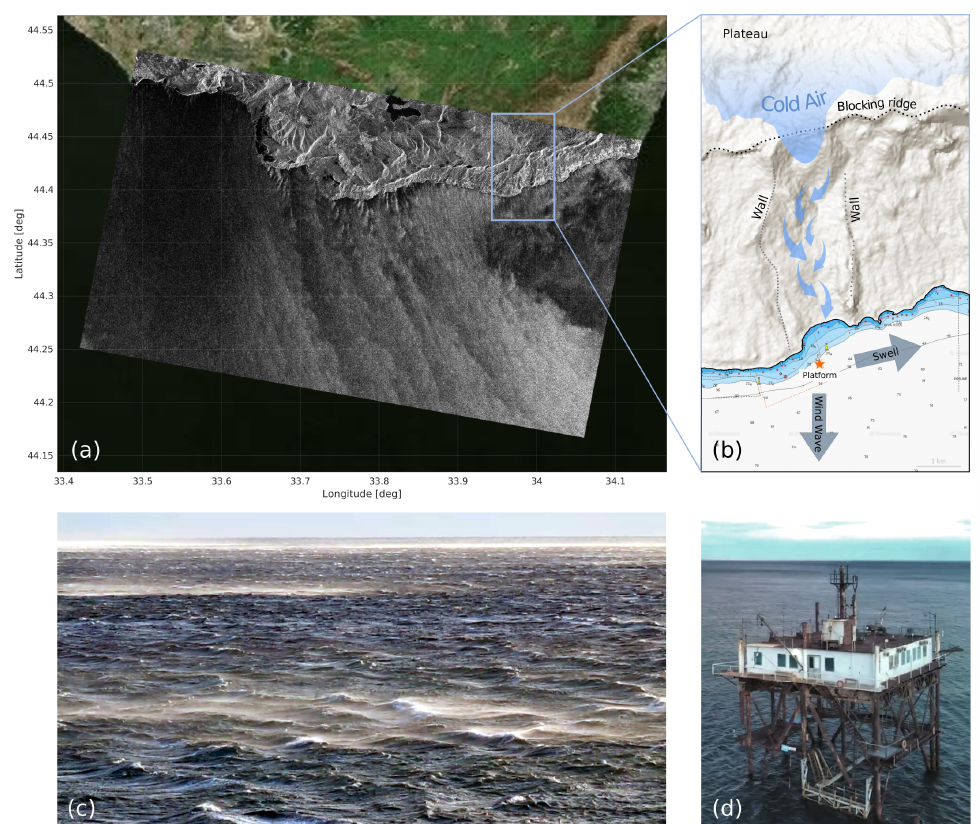
Figure 1. Experiment overview: ( a ) Sentinel-1A Synthetic Aperture Radar (SAR) VV image taken at 03:57UTC on 25 October 2018, ( b ) map of coastal line, water depth, and mountain elevation with schematic explanation of gap (katabatic) wind formation, ( c ) quasi-synchronous photo taken from the platform during Sentinel-1A overpass, ( d ) platform aerial